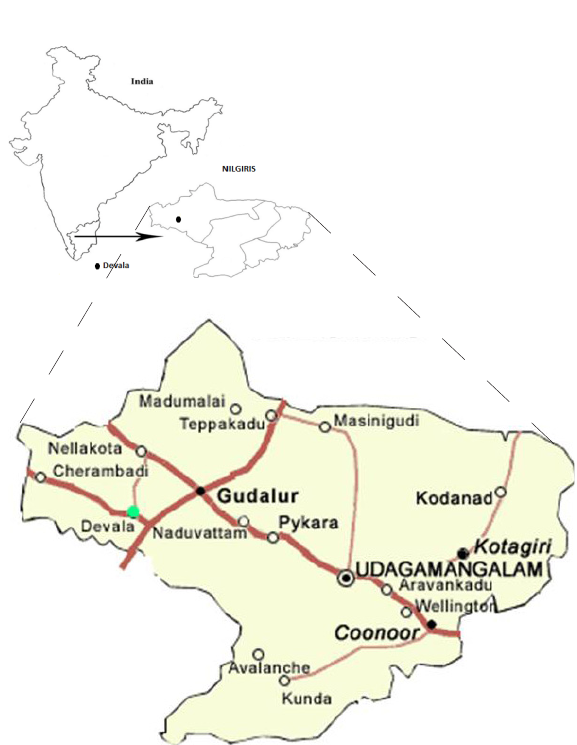
Image 2. Study area (green circle) indicates the locality of Memecy- lon clarkeanum